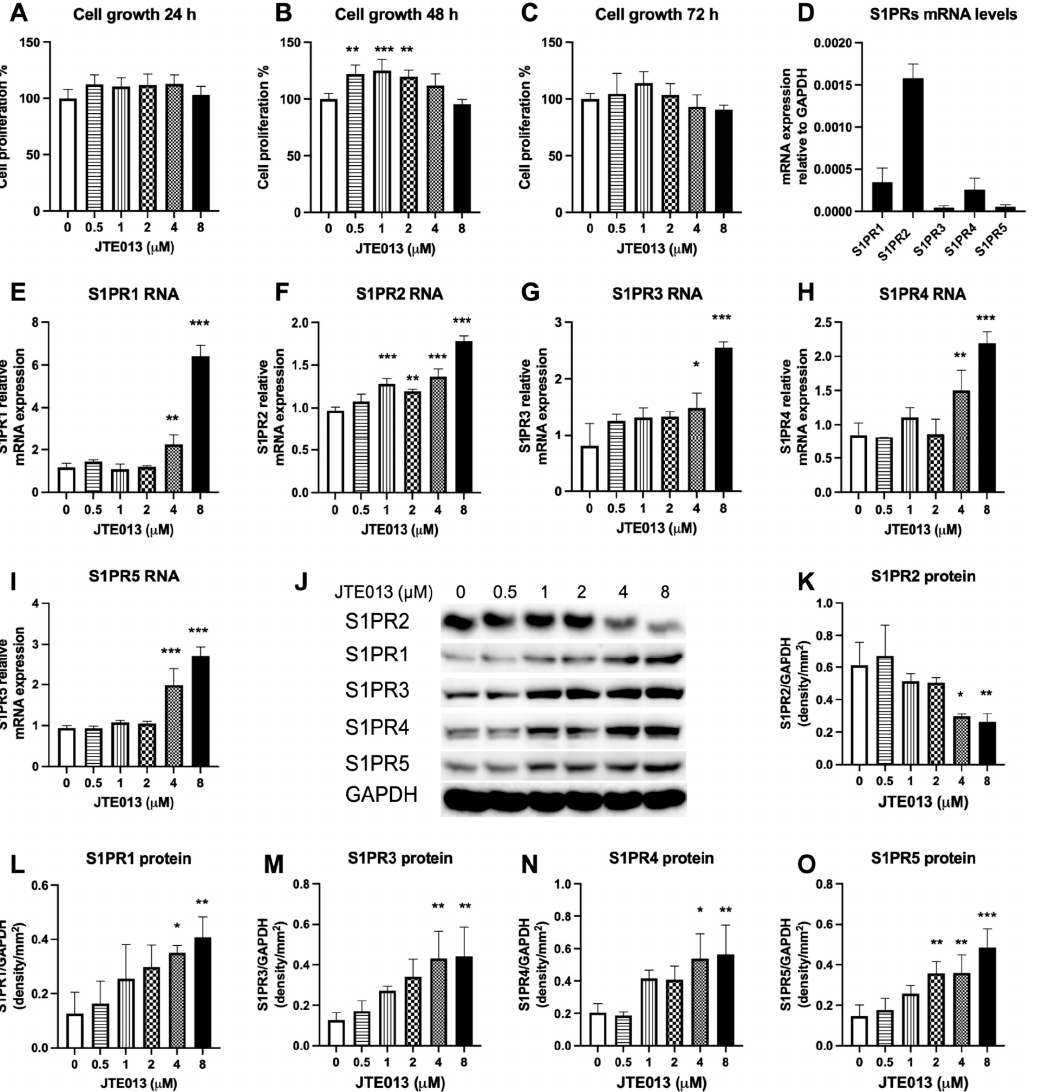
Figure 1. Effects of JTE013 on cell growth and S1PRs expressions. Murine BMSCs were cultured in osteogenic media for 1 to 3 days with the presence of either DMSO or JTE013 (0.5 to 8 μ M). Cell growth at ( A ) 24 h, ( B ) 48 h, and ( C ) 72 h was quantified by a CellTiter 96 ® AQueous One Solution Cell Proliferation Assay. ( D ) Relative S1PRs’ mRNA levels in murine BMSCs cultured in DMEM media with 10% FBS and 100 U/mL penicillin and streptomycin. ( E – I ) Murine BMSCs were treated with either DMSO or JTE013 (0.5 to 8 μ M) and cultured in osteogenic media for 7 days. ( E ) S1PR1, ( F ) S1PR2, ( G ) S1PR3, ( H ) S1PR4, and ( I ) S1PR5 mRNA levels were quantified by RT-qPCR and normalized by GAPDH expression. (n = 3, * p < 0.05, ** p < 0.01, ** p < 0.001). ( J – O ) Murine BMSCs were treated with either DMSO or JTE013 (0.5 to 8 μ M) and cultured in osteogenic media for 9 days. ( J ) S1PR2, S1PR1, S1PR3, S1PR4, S1PR5, and GAPDH protein levels were measured by Western blot. Protein densitometry of ( K ) S1PR2, ( L ) S1PR1, ( M ) S1PR3, ( N ) S1PR4, and ( O ) S1PR5 was normalized by GAPDH protein expression in BMSCs (n = 3, * p < 0.05, ** p < 0.01, *** p < 0.001).